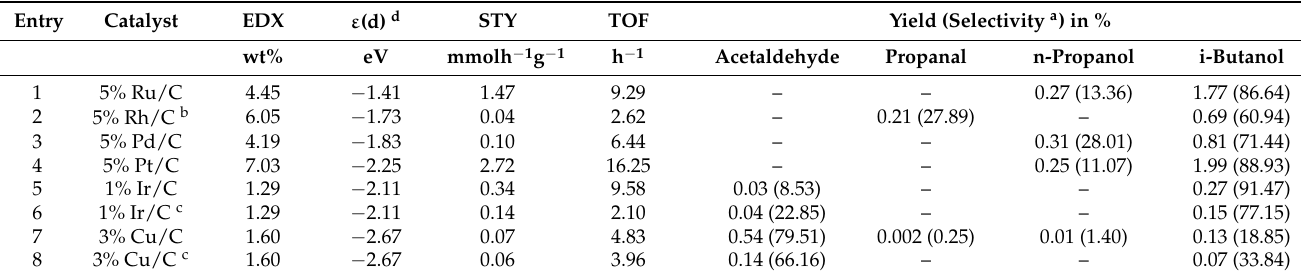
Table 4. Results of the catalytic tests: t(Reaction) = 4 h, T = 150 ◦ C, m(Catalyst, wet) = 250 mg, c(NaOH) = 450 mmol/L, c(EtOH) = 600